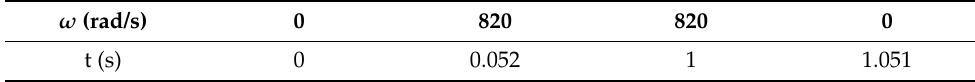
Table 6. Acceleration and deceleration method measurement results.